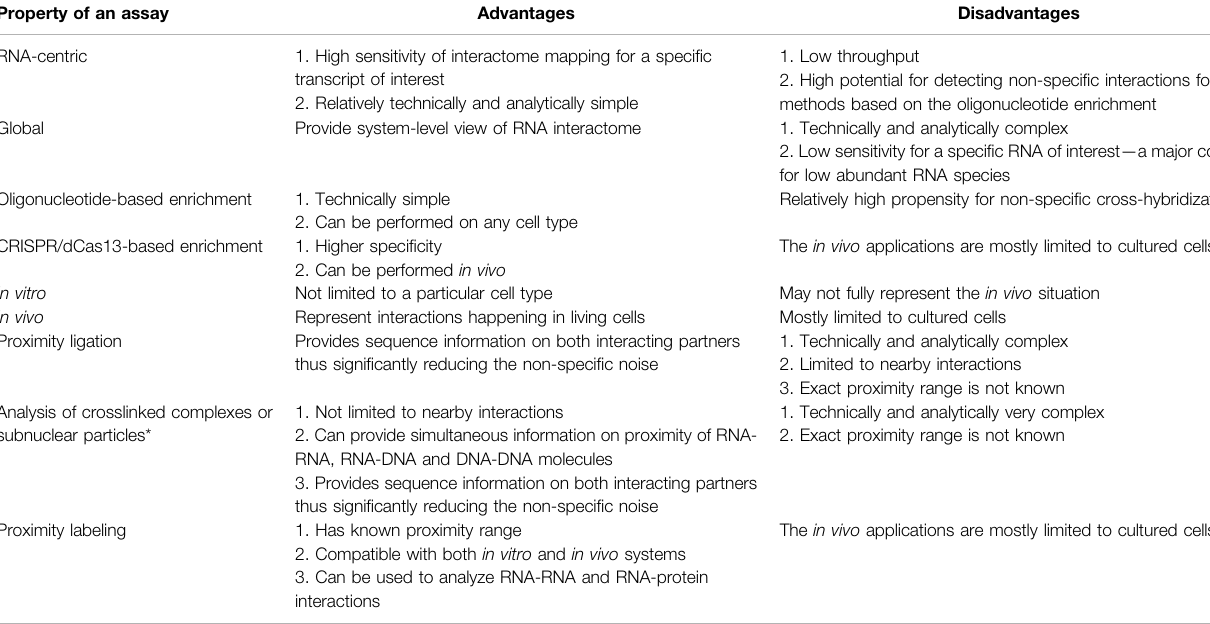
TABLE 2 | Advantages and disadvantages of different properties of RNA interactome mapping